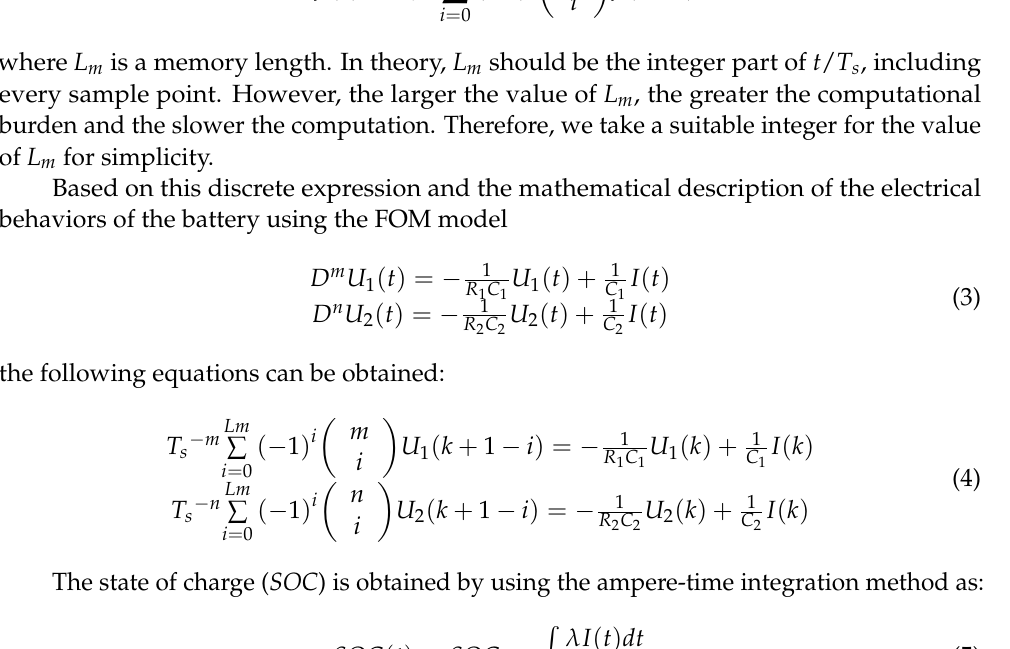
double layer effect. U 1 and U 2 are the voltages of the loops. C 1 and C 2 are the abbreviations